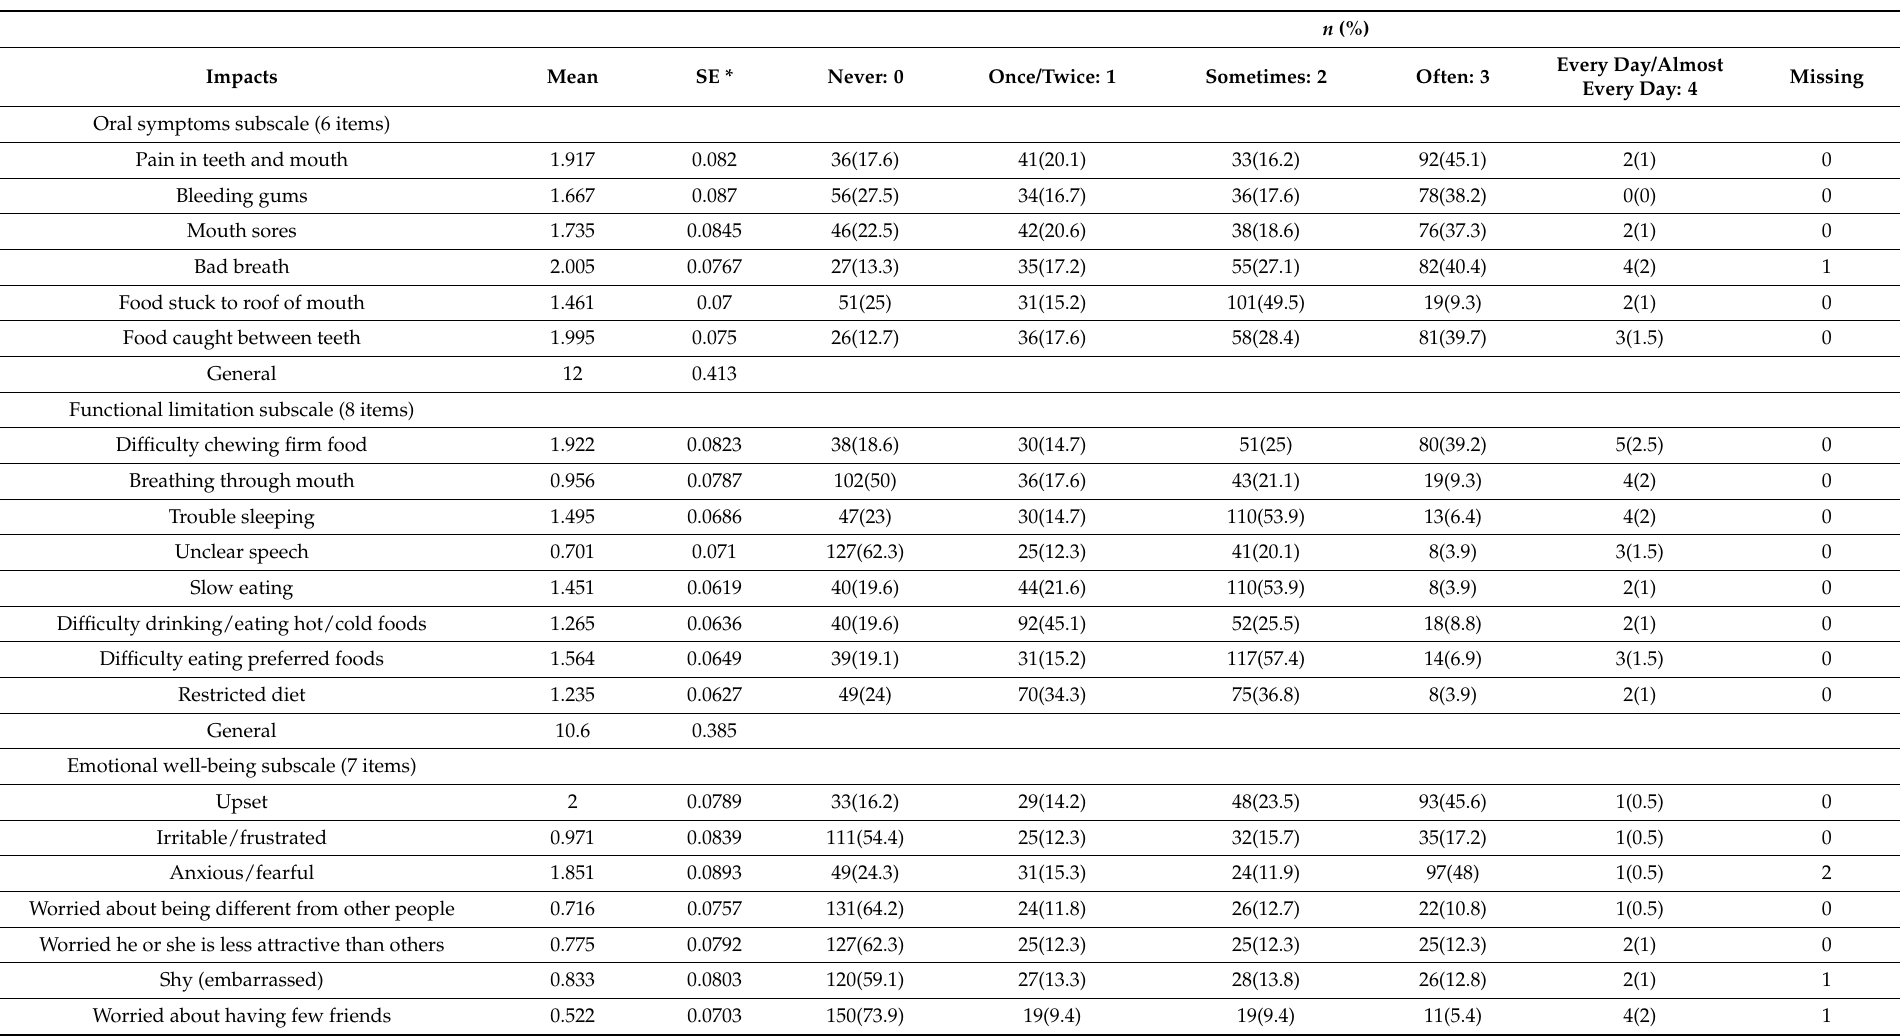
Table 3. Descriptive statistics and summary of Parental Caregiver Perception Questionnaire (P-CPQ) responses ( n =